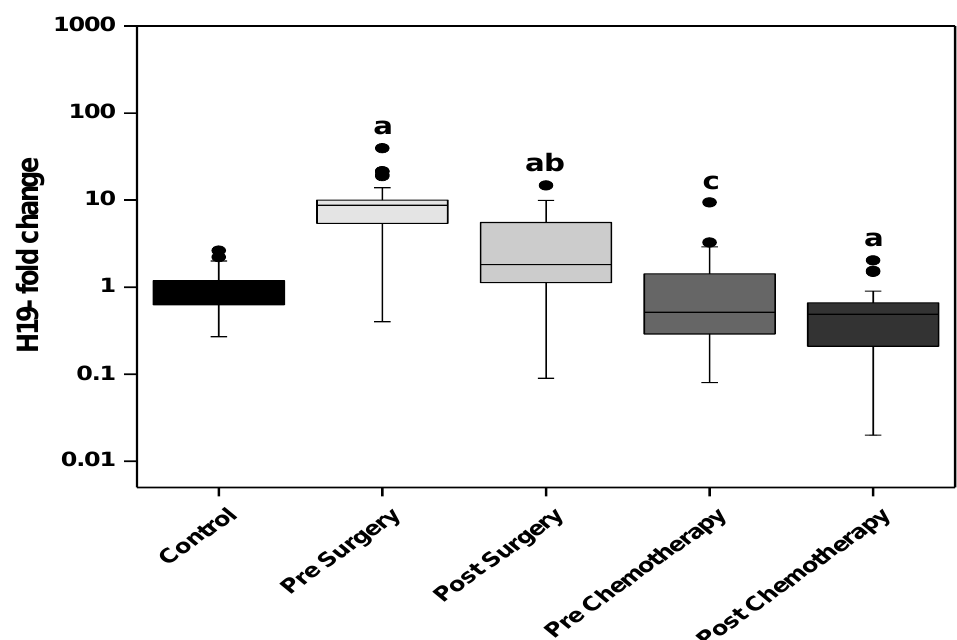
Figure 2. The circulating levels of H19 in the control subjects and the BC studied groups; surgery only and adjuvant chemotherapy. Extreme value: a—Significant between control and each group by using Post Hoc Test (Dunn’s), Kruskal Wallis test, b—Significant between pre and post in same group by using Wilcoxon signed ranks test, c—Significant between post-surgery and prechemotherapy by using Mann Whitney test.